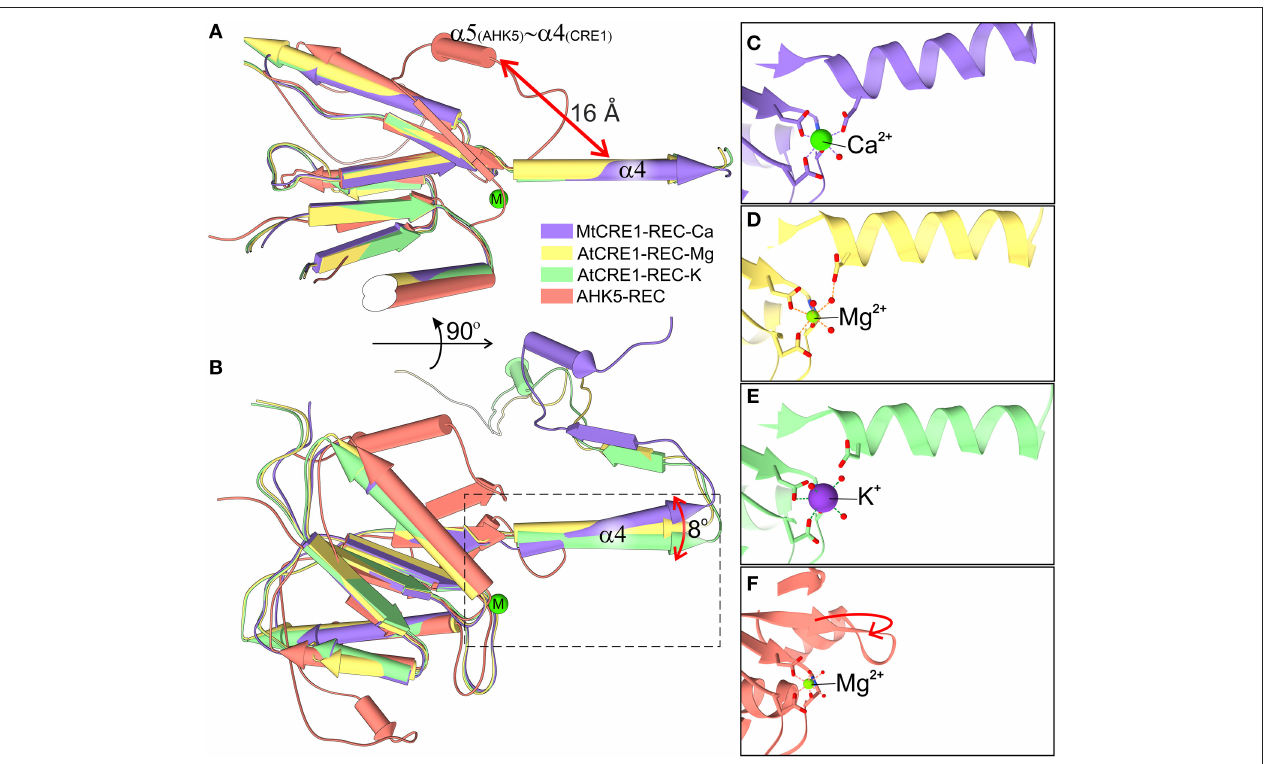
FIGURE 4 | Superposition of four structures of the REC domain (MtCRE1-REC-K in purple, AtCRE1-REC-Mg in yellow, AtCRE1-REC-K in green, AHK5-REC in salmon). They are shown in pipe ( α helix) and plank ( β strand) representation in two views (A,B) emphasizing the different orientation of helix α 4 in the domain-swapped and unswapped states and (B) the variable orientation of helix α 4 in the domain swapped structures with different metal cations. The active site is shown in stick representation for MtCRE1-REC-Ca (C) , AtCRE1-REC-Mg (D) , AtCRE1-REC-K (E) and AHK5-REC (F) , where the red arrow indicates the helix unswapping